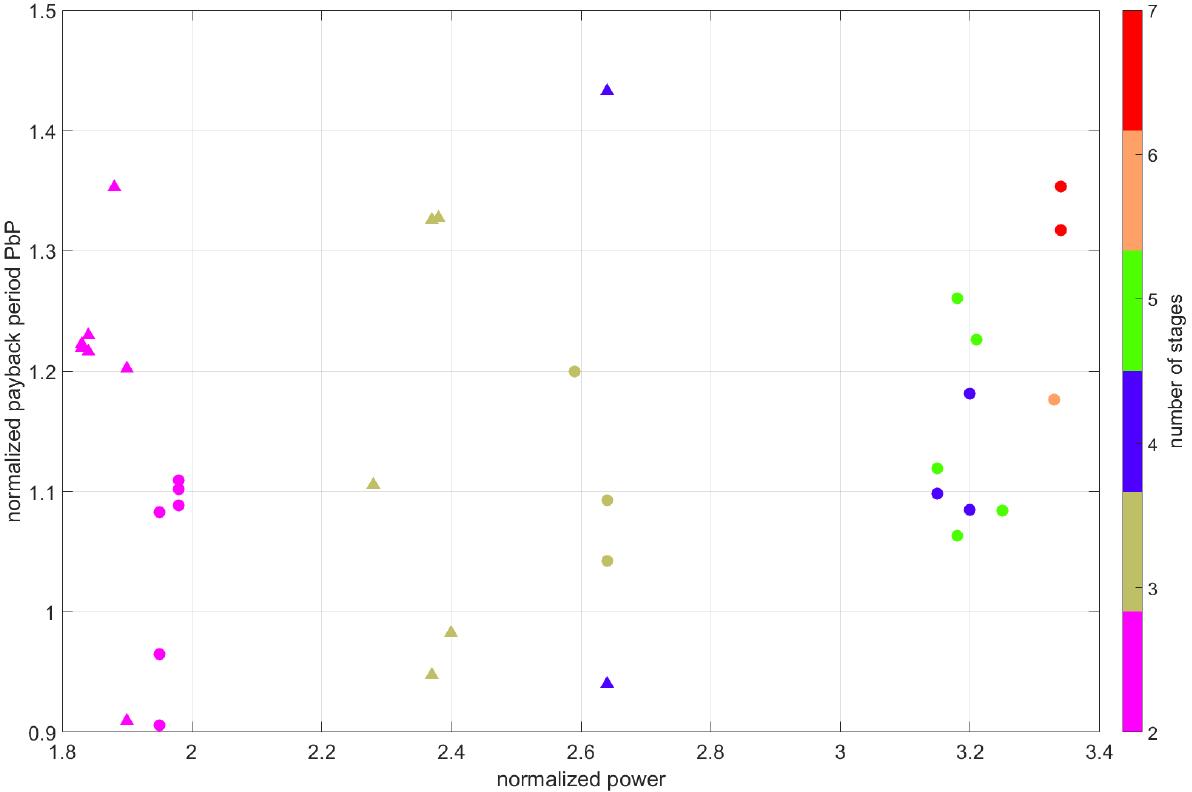
Figure 8. Analysis of available cases for two initial temperatures T 1 (Circles: T = 535 K; Triangles: T = 550 K), normalized payback period PbP m vs. normalized generated power P Σ for multi-stage expansion, the number of stages N is color-coded P PbP as shown in the legend (refer to Tables A1 and A2 in the supplementary